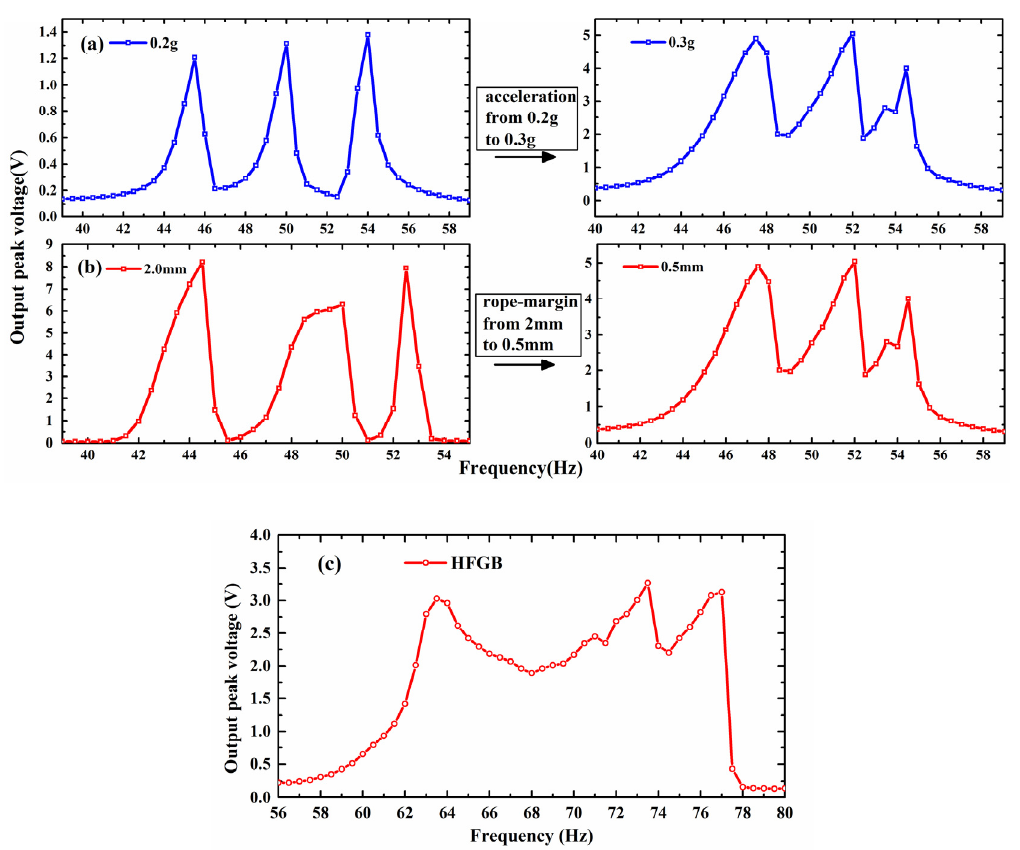
Figure 9. Adjustable performance by changing ( a ) acceleration, ( b ) rope margin, and ( c ) rope margin and LFDBs’ stiffness, simultaneously.